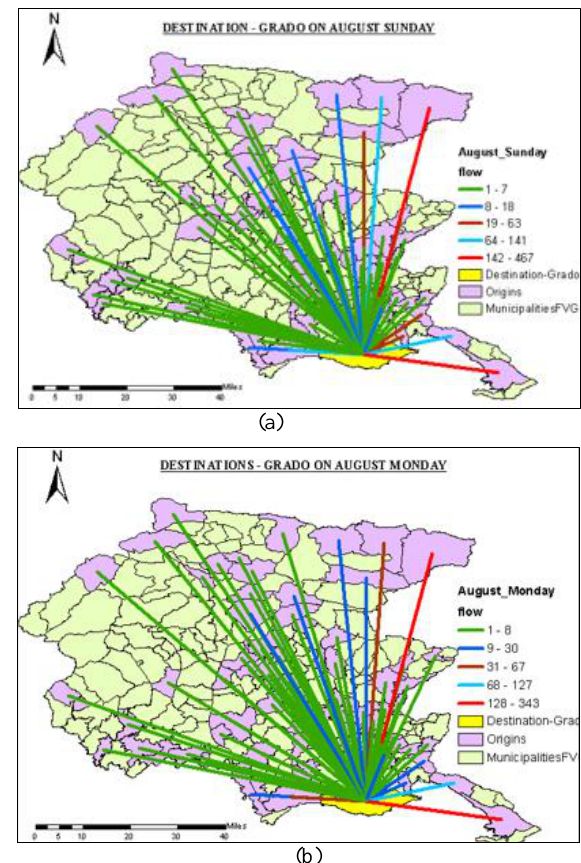
Figure 3.1.2-4 (a) & (b) OD flows for Foreigners August Sunday and Monday  The above fig.3.1.2-4 show flow count for foreigners. The Count flow on Sunday in Grado is 400. While on Monday, the flow is